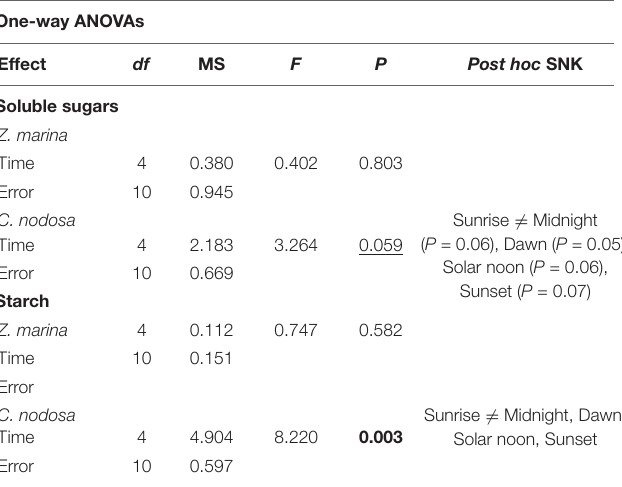
TABLE 5 | Results of one-way ANOVAs to assess the effects of time of the day on TNC accumulation (soluble sugars and starch) in Zostera marina and Cymodocea nodosa